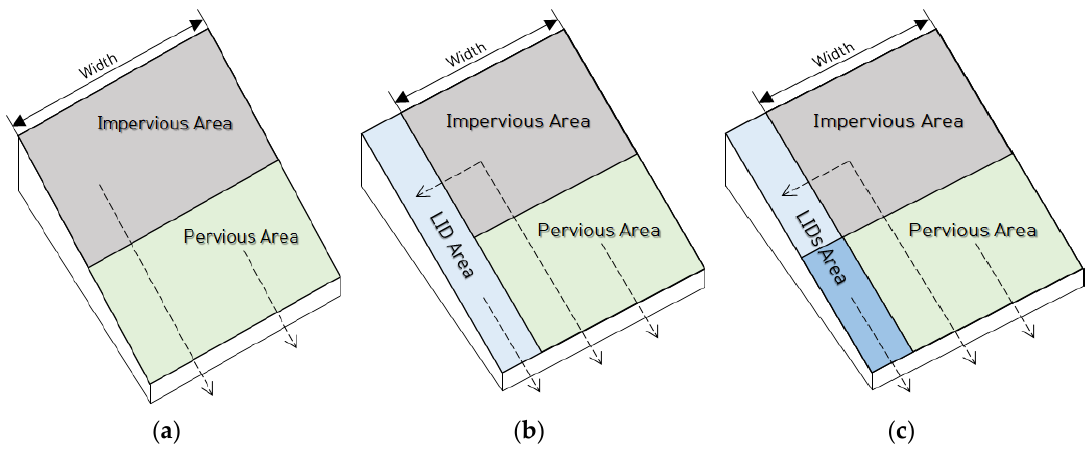
Figure 3. Concept of subcatchment classification according to LID facility application [45–47] ( a ) Before LID; ( b ) After LID (Type A); ( c ) After LIDs (Type B).